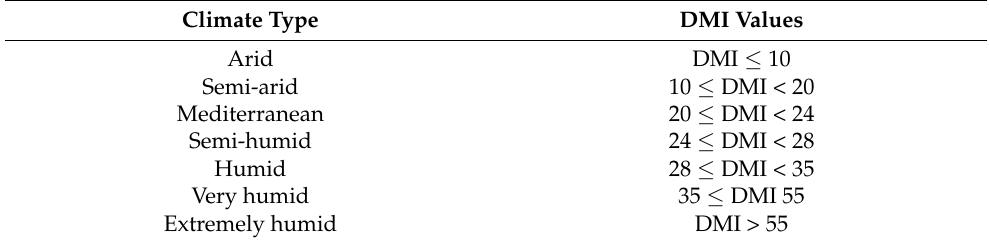
Table 2. Classification of the different climatic types according to the De Martonne index (DMI)